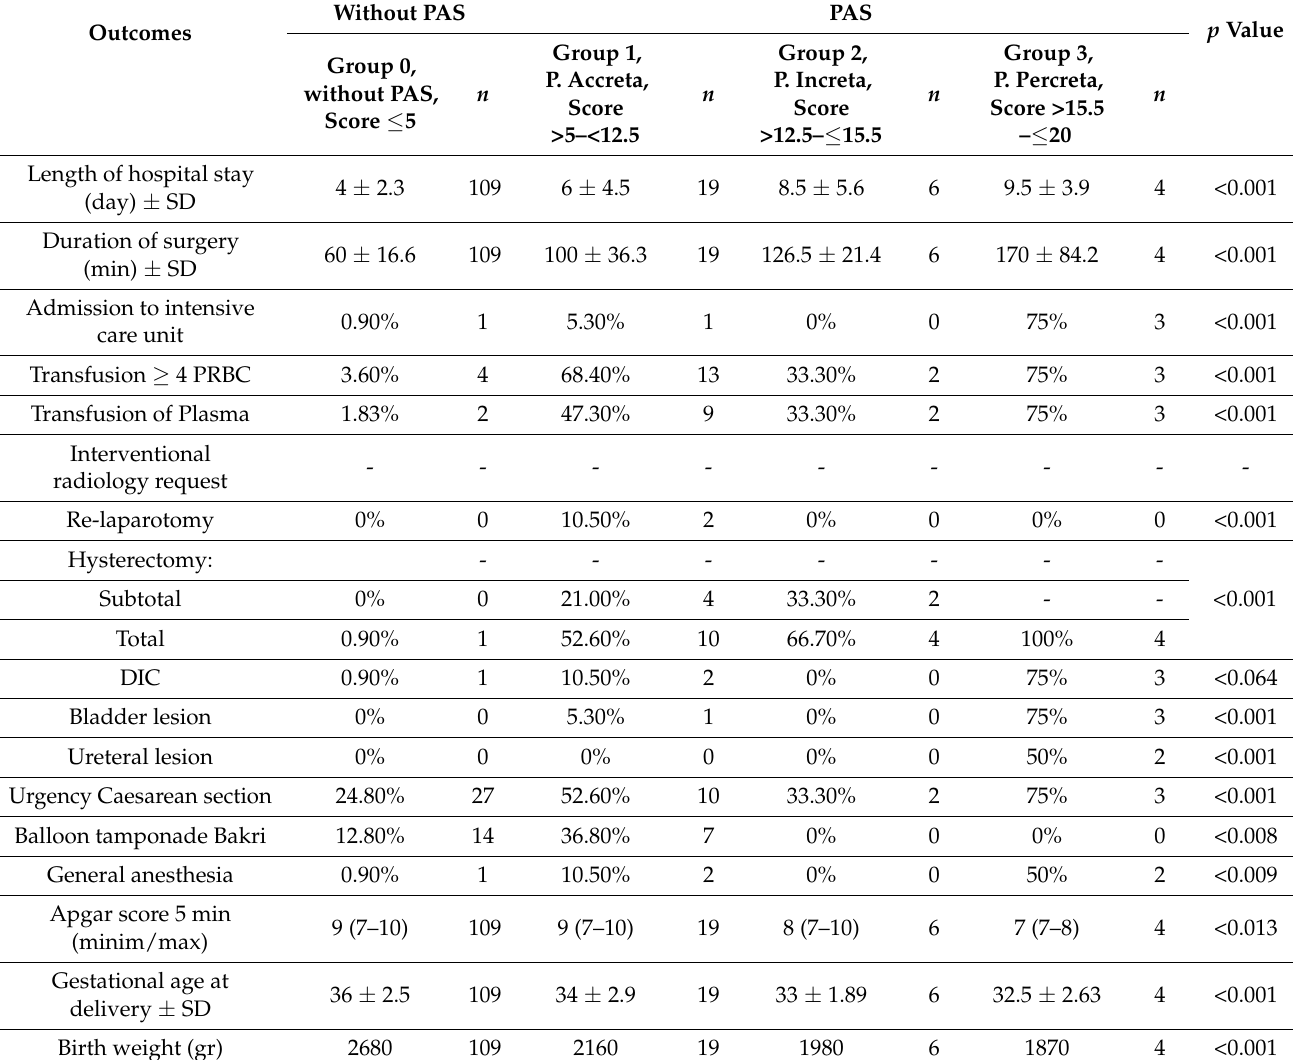
Table 5. Surgical and neonatal outcomes according to the score of